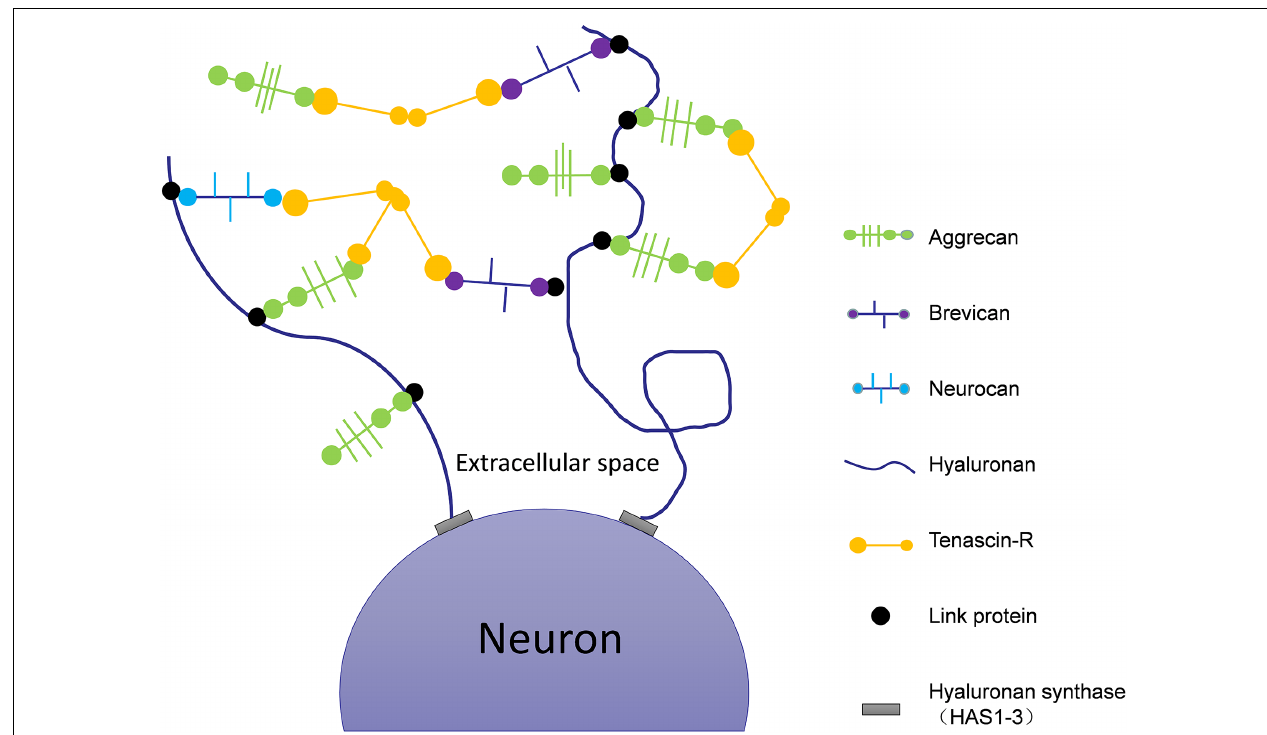
FIGURE 2 | Schematic of the molecular composition of PNNs. Hyaluronan synthases are located at the neuronal cell membrane, synthesizing hyaluronan and secreting it into the perineuronal area. Members of the lectican family (aggrecan, neurocan, and brevican) bind to the hyaluronic backbone. Link proteins stabilize the binding of CSPGs to hyaluronan. Tenascin-R (TNR) crosslinks the lecticans to form stable